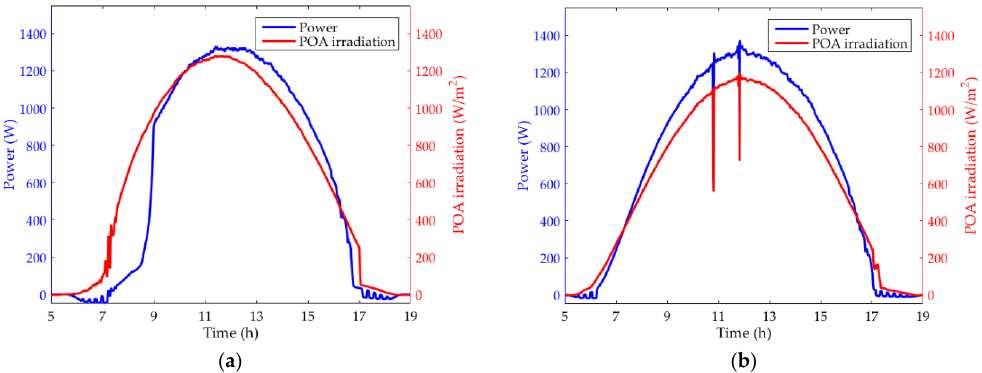
Figure 5. Observed power and POA irradiation: ( a ) 25 March 2013; ( b ) 14 April 2013.